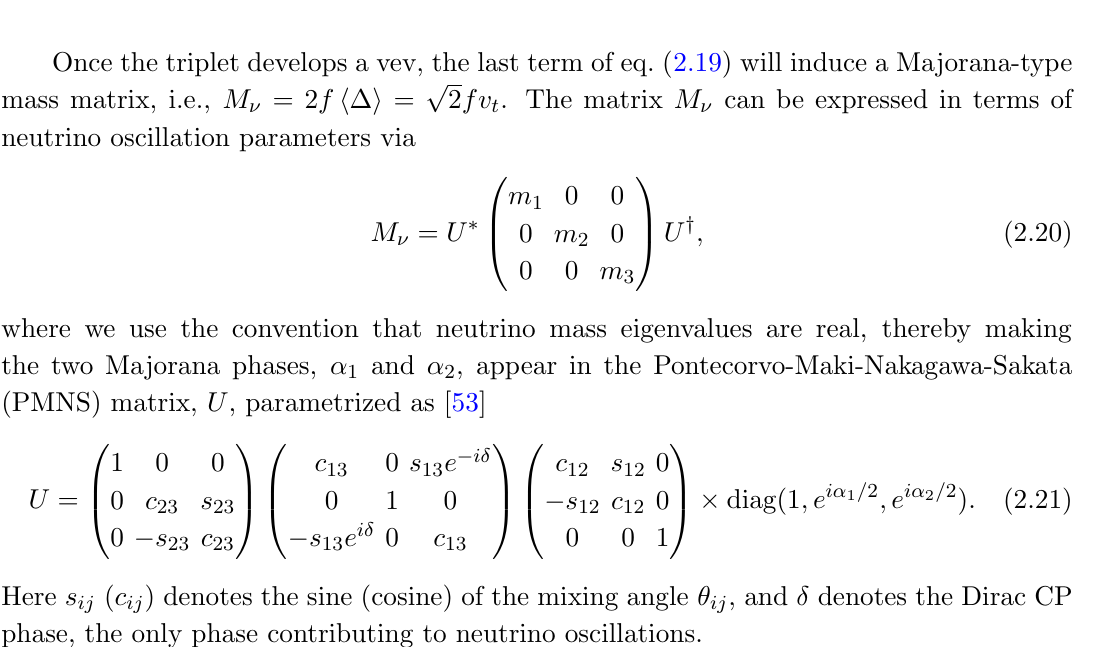
(cid:17) (cid:1) m 2 in Inverted Hierarchy atm : 32